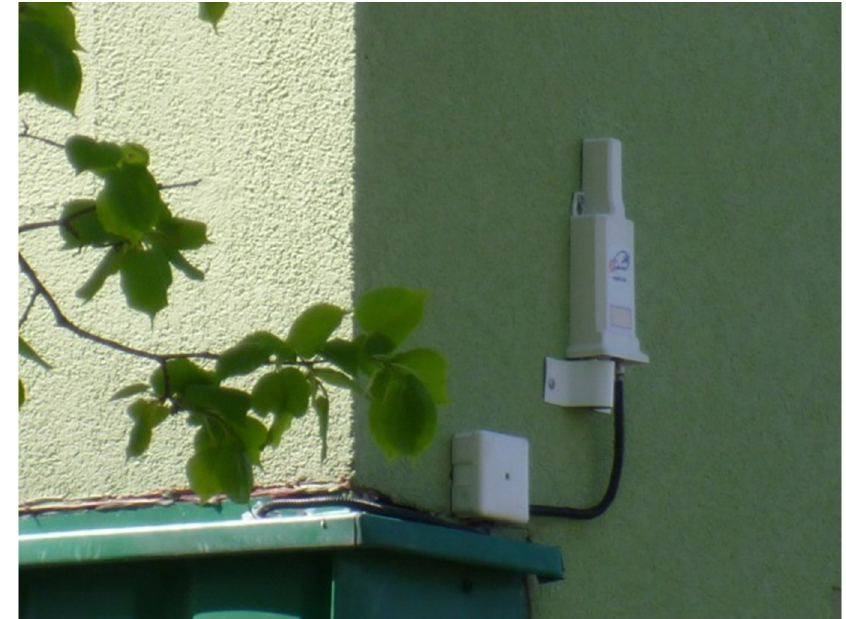
Figure 1. Weather forecast receiver Egain Hub, building A at 12 ´Sniadeckiego St. in Łom˙za.